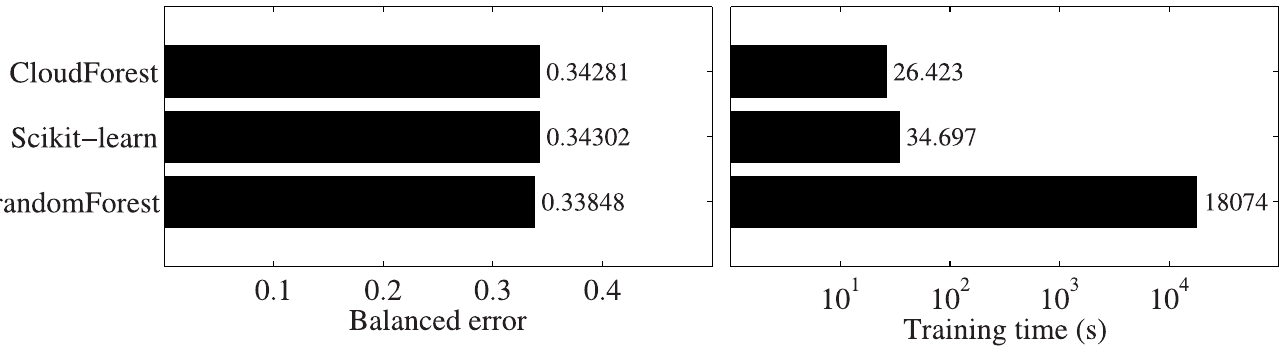
Fig 1. Comparison between CloudForest and other RF implementations in terms of prediction performance ( a ) and training time ( b ). The RFs consisted of 500 trees and were trained using the same standard parameter settings for all